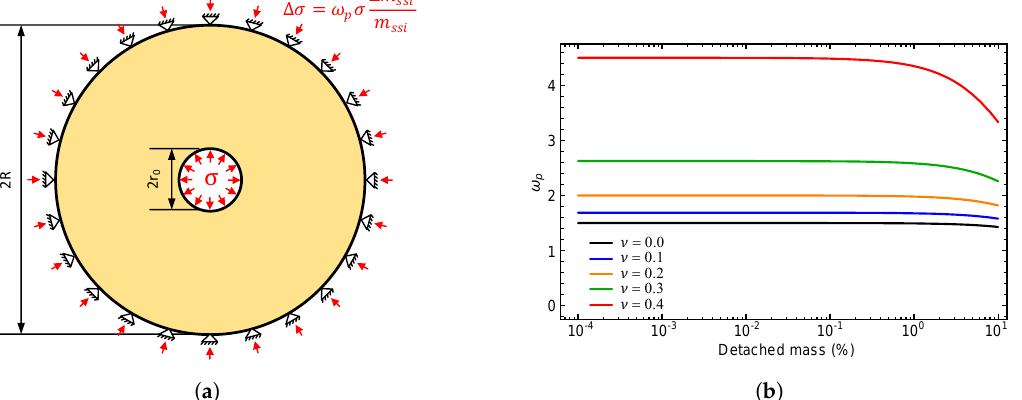
Figure 1. Linear elastic approach for evaluating spherical stress relaxation: ( a ) illustration of the analytical boundary value problem; ( b ) ω p as a function of detached mass (colors represent different Poisson’s ratio).